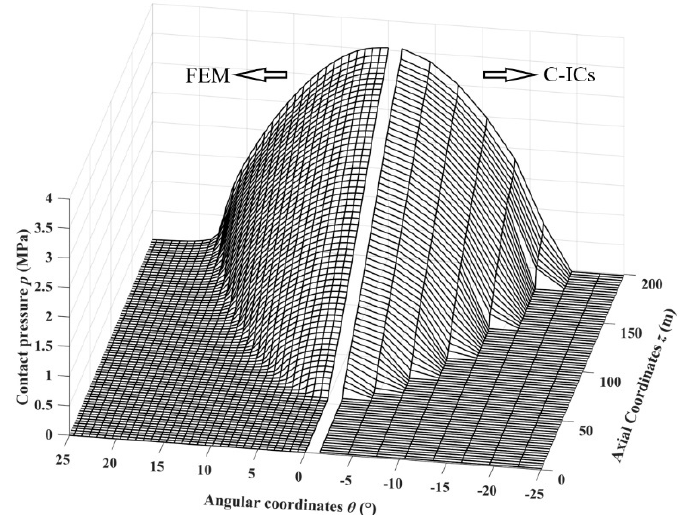
Figure 9. FEM results for straight shaft when Φ = 0.02° and δ max = 0.05 mm: ( a ) result of contact pressure; ( b ) result of radial displacement.